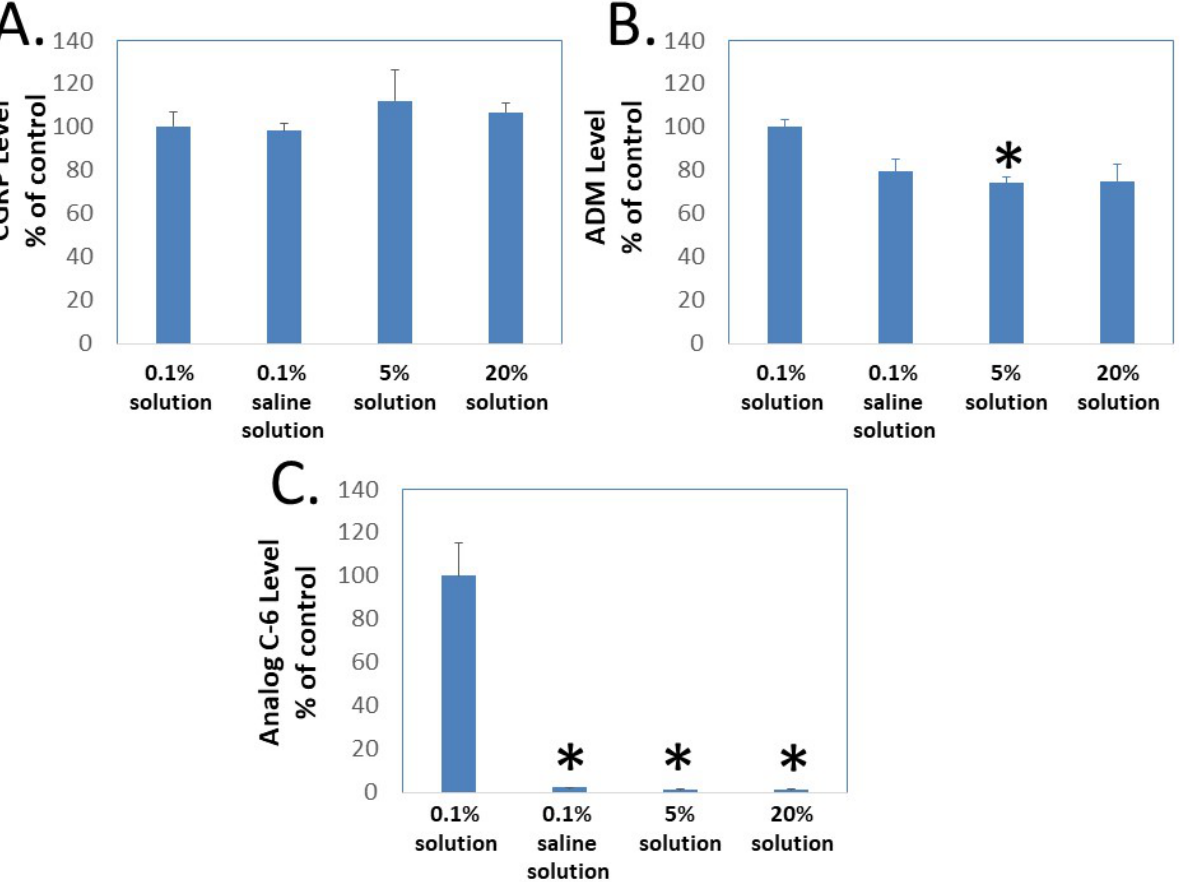
Figure 5. Gel formation hinders the passage of Analog C-6 molecules through Centricon mem- brane filters. To determine whether gel formation reduces the peptide’s freedom to move, we analyzed the passage of ( A ) CGRP, ( B ) ADM, and ( C ) Analog C-6 molecules through the Centricon membrane filter (MW cutoff: 30,000). The testing solutions included 0.1% peptide in 5% glucose (0.1% solution), 0.1% peptide in saline solution as well as 5% and 20% peptide in 5% glucose (5% and 20% solution). For 5% and 20% solution, one-milligram aliquots of the peptides were first dissolved at the target concentration and diluted to the 0.1% level 10 min later. Aliquots of these solutions were then dispensed into individual Centricon columns before centrifugation for 15 min (2000 × g ). Levels of peptides in the elute were determined by specific CGRP or ADM EIA. *, Significantly different from the 0.1% solution control group. Data are mean ± SEM of triplicate